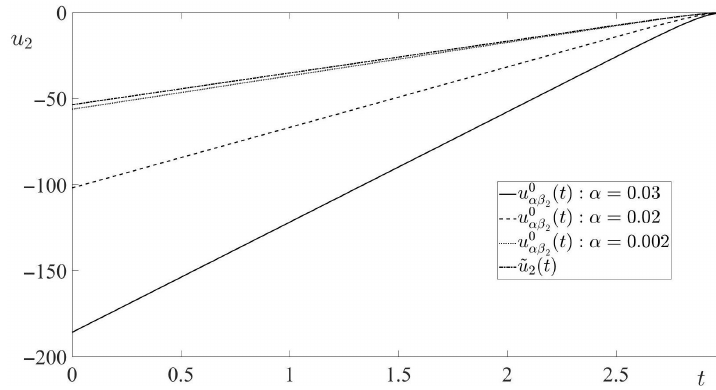
( t ) and limiting function ˜ u αβ 2